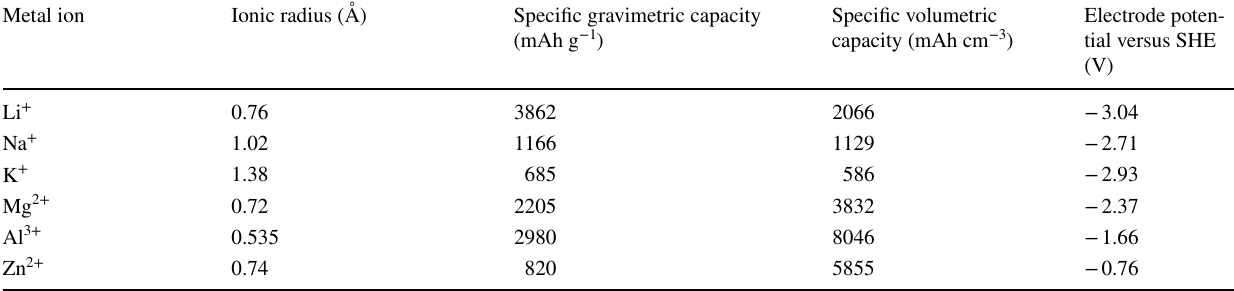
Table 1 Comparison of several metal-ions batteries including ionic radius, specific capacity and standard electrode potentials [14]. Copyright 2018, ACS Publication